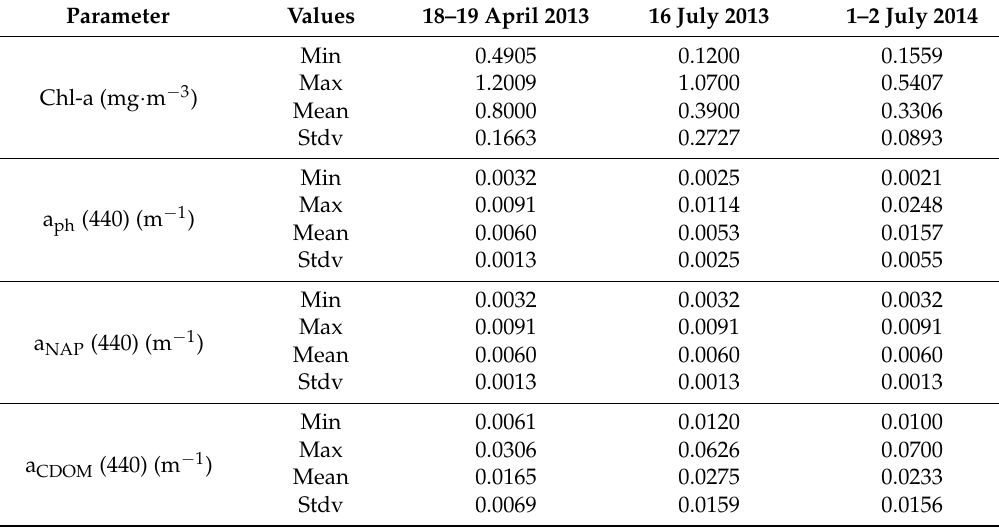
Table 1. Descriptive statistics of chl-a and IOP derived during the three measurement campaigns. Parameter